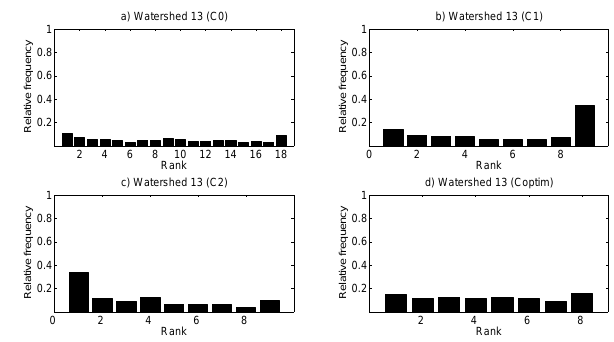
Fig. 14. Box plot of the CRPS over the 1061 catchments, as a func- tion of the number of models per optimized subsets.